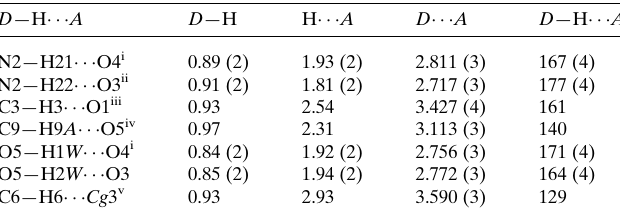
Table 3 Hydrogen-bond geometry (A˚ , (cid:5) ) for (III). D —H (cid:2)(cid:2)(cid:2) A